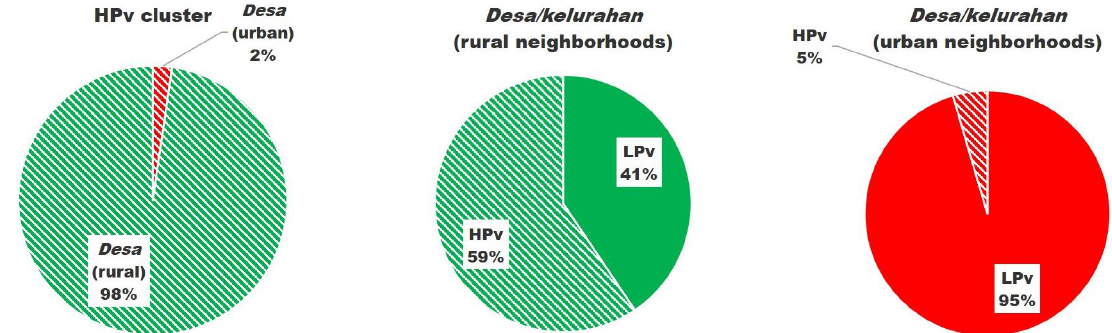
Figure 7. Percentage (composition) of desa/kelurahan for the HPv and LPv clusters. Most rural neighborhoods of the HPv cluster are clustered in the northern part of Bekasi Regency, particularly in DA 3 (Figure 8). All subdistricts in DA 3 and DA 4 have desa/kelurahan s in Type IV (HPv cluster and rural neighborhood) (Figure 8). Interestingly, four subdistricts, all of which are rural neighborhoods, are included in the HPv cluster, namely Muara Gembong (DA 4), Pebayuran (DA 3), Tambelang (DA 3), and Sukawangi (DA 3) (Figure 8). Two desa/kelurahan (urban neighborhoods) that belong to the HPv cluster are located in the center of urban areas (Cikarang Utara subdistrict), and one is in the Tambun Utara subdistrict (Figure 8). Interestingly, there is one subdistrict in DA 1 where all desa/kelurahan are all urban neighborhoods and belong to the LPv cluster, namely, Tambun Selatan (Figure 8).